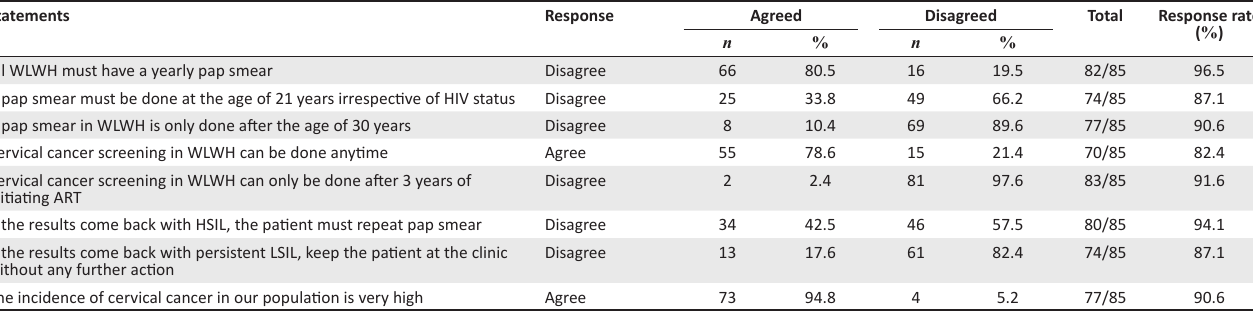
TABLE 3: Responses of healthcare workers to statements of cervical cancer in women living with human immunodeficiency virus ( n = 85). †